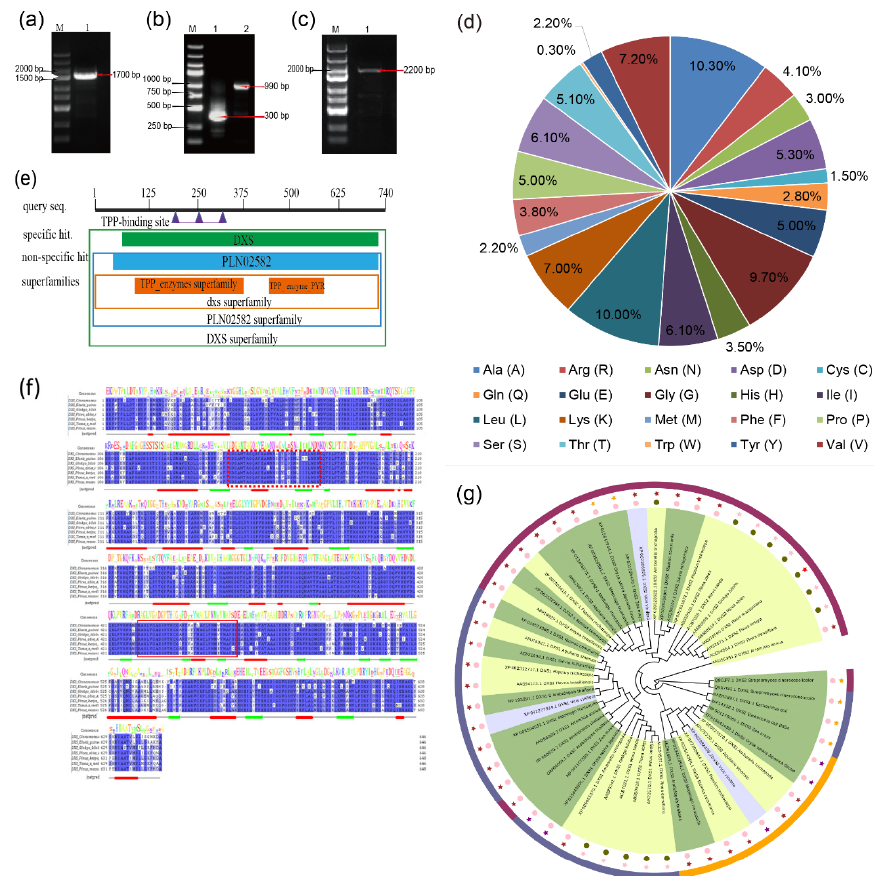
Figure 1. Cloning and sequence analysis of PmDXS . ( a ) The cloning of the intermediate fragment (1. PCR amplification production of the intermediate fragment). ( b ) The cloning of the two end sequences (1. PCR amplification product of the 3 ′ RACE fragment; PCR amplification product of the 5 ′ RACE fragment). ( c ) The cloning of the ORF fragment (1. PCR amplification product of the ORF fragment). ( d ) The number and proportion of amino acids in the PmDXS protein. ( e ) Prediction of conservative protein sequences encoded by PmDXS . ( f ) Amino acid sequence alignment of PmDXS from P. massoniana and other plants. Thiamine diphosphate binding sites are marked by dotted box lines, and transketolase do- mains are marked by solid box lines. The “jnetpred” in the picture represents the prediction result of the secondary struc- ture of DXS protein: α -helices are represented by red tubes, and β -sheets are represented by green arrows. ( Cinnamomum micranthum RWR84357.1, Elaeis guineensis XP_010933574.1, Ginkgo biloba AAR95699.1, Picea abies ABS50520.1, Pinus kesiya AIY22671.1, Pinus massoniana MK970590, Taxus × media AAS89342.1). ( g ) Molecular phylogenetic tree of PmDXS. Back- ground colors: dark green represents herbaceous plants, light green represents woody plants, light blue represents vines. Colors of outer bars: dark blue represents DXS type I, purple–red represents DXS type II, orange represents DXS III Type. The color of the stars: brown represents dicots in angiosperms, pink represents gymnosperms, purple represents monocots in angiosperms, orange represents fungi. Color of dots: pink represents angiosperms, green represents gymnosperms plant. ( Amborella trichopoda DXS1 XP_006855370.1, DXS2 XP_020523522.1, DXS3 XP_020529570.1, Aquilaria sinensis DXS1 AFU75321.1, DXS2 AHI62962.1, DXS3 AFU75320, Arabidopsis thaliana DXS1 NP850620.2, DXS1-2 NP193291.1, DXS2 OAP04569.1, DXS3 AED91669.1, Ginkgo biloba DXS1 AAS89341.1, DXS2 AAR95699.1, Hevea brasiliensis DXS1 AAS94123.1, DXS2 ABF18929.1, Oryza sativa DXS1 XP_015640505.1, DXS2 XP_015647944.1, DXS3 XP_015642490.1, Pinus densiflora DXS1 XP_015640505.1, DXS2 ACC54554, Pinus taeda DXS1 ACJ67021, DXS2 ACJ67020.1, Pinus kesiya DXS1 AIY22671.1, DXS2 AIY22670.1, Populus trichocarpa DXS1 XP_002312717.1, DXS2-1 XP_002303416.1, DXS2-2 XP_002331678.1, DXS3 XP_002308644.1, Ricinus commol/Lunis DXS1 XP_015573388.1, DXS2-1 XP_002532384.1, DXS2-2 XP_002533688, DXS3